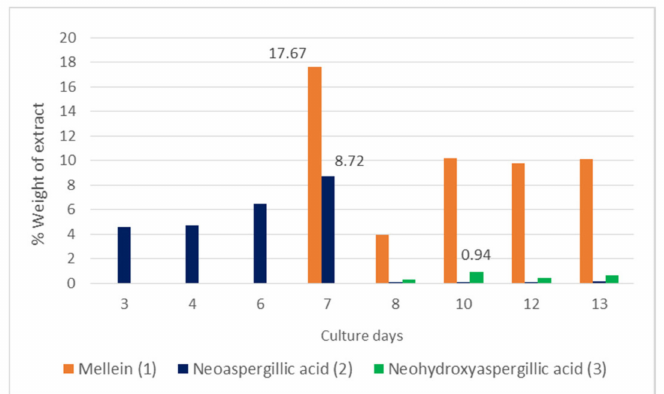
Figure 3. Time-course production of compounds 1 – 3